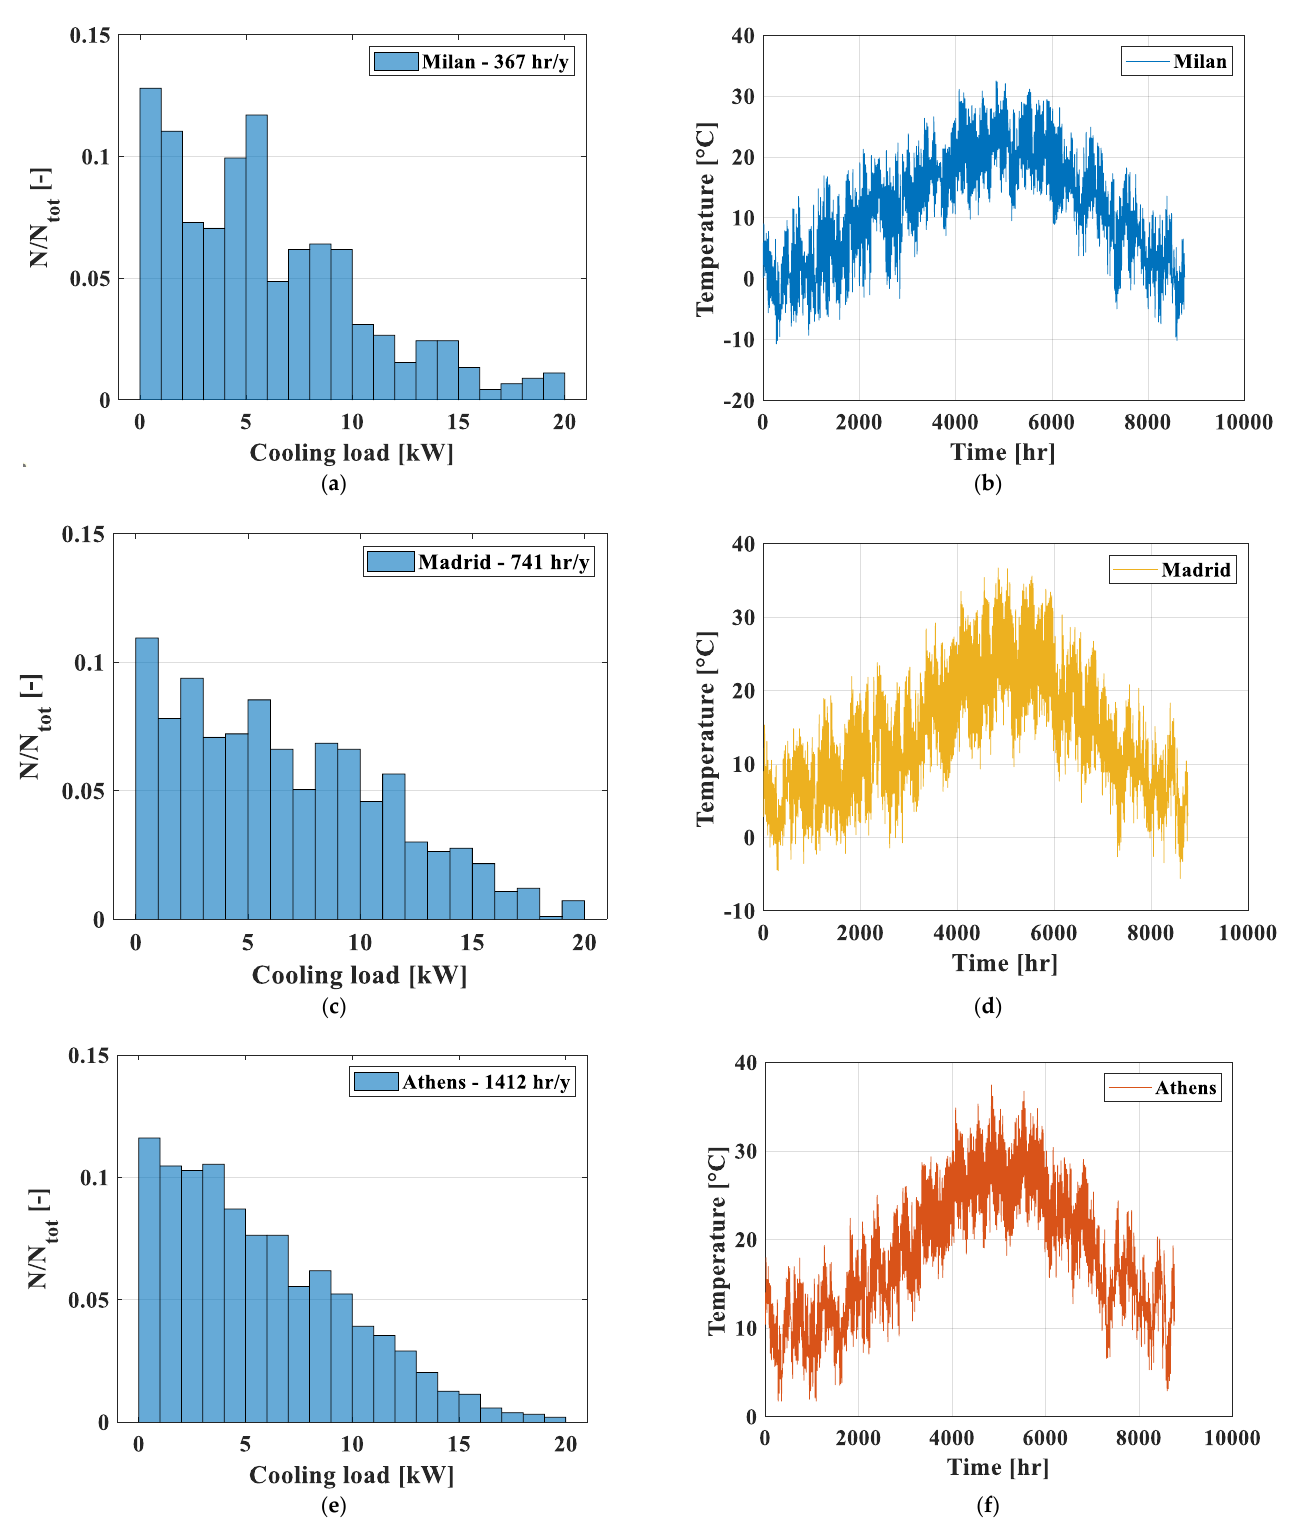
Figure 6. Cooling load profile and seasonal hourly temperature profile for Milan ( a , b ), Madrid ( c , d ), Athens ( e , f ).